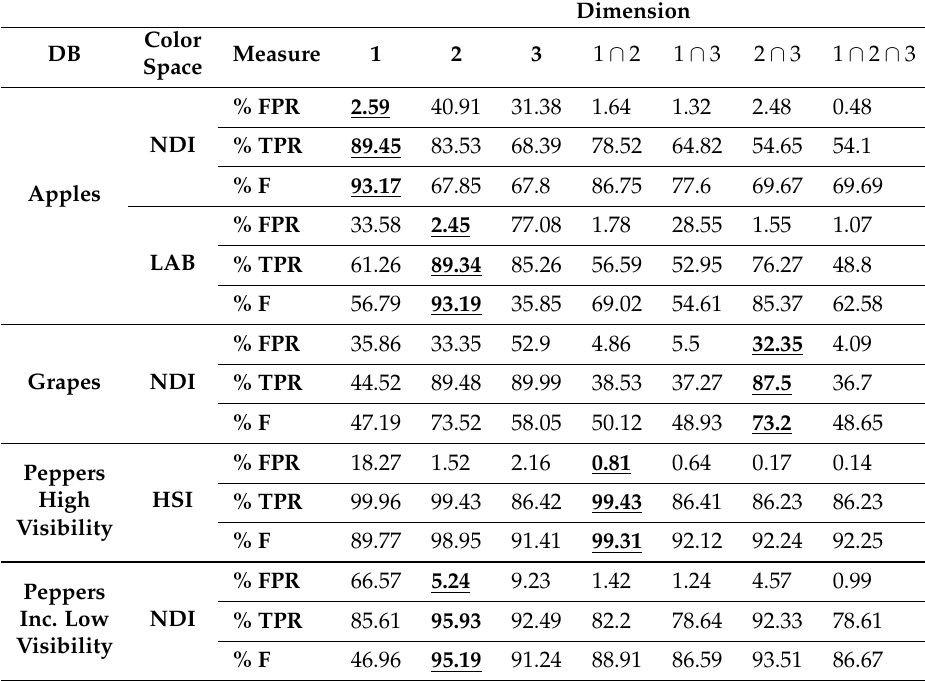
Table 5. Performances of each color space for each dimension and intersection for all datasets.